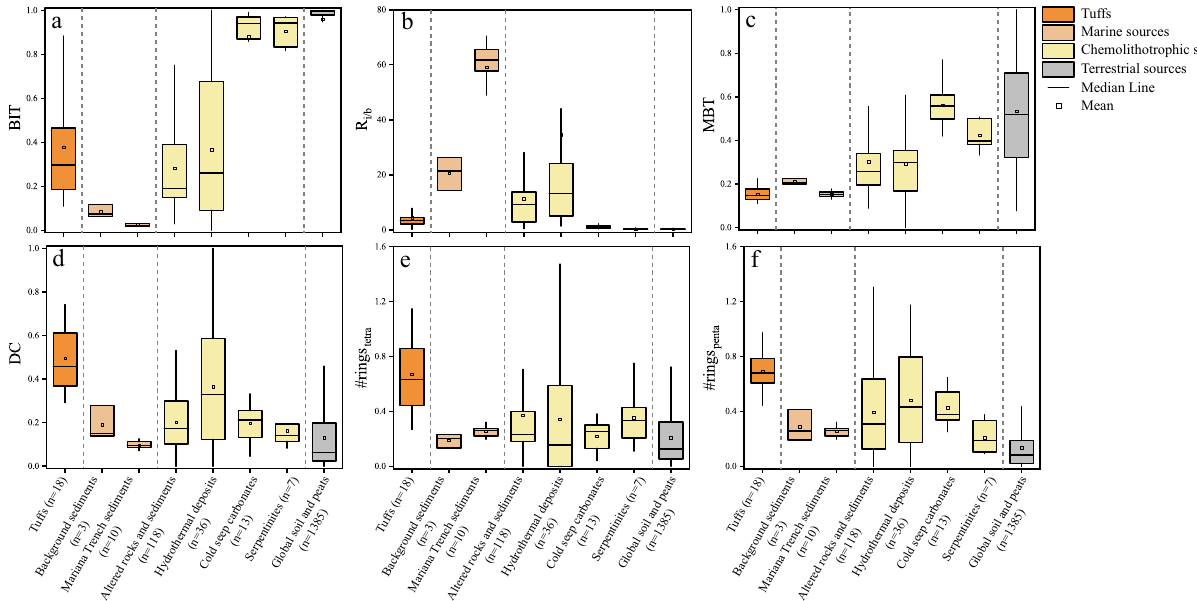
Fig. 6 Distribution range of brGDGTs proxies in different environments. The box plots of a BIT index, branched isoprenoid tetraether; b R i/b , abundance ratio of isoGDGTs and brGDGTs; c MBT, degree of methylation of brGDGTs; d DC, degree of cyclization of brGDGTs; e , f #rings tetra and #rings penta , the weighted average number of cyclopentane moieties for tetra- and penta-methylated brGDGTs, respectively. Error bars indicate the range within 1.5 IQR. The dark and light orange color represent tuffs and marine samples, respectively; while samples from chemolithotrophic systems and land are represented by yellow and gray, respectively. Data sources: tuffs and background sediments from this study, Mariana Trench sediments 32 , altered rocks and sediments 25,26,35 , hydrothermal deposits 28,42 – 45 , cold seep carbonates 27 , serpentinites 37 , and the data source of global soil and peats datasets please see Supplementary References 9 –